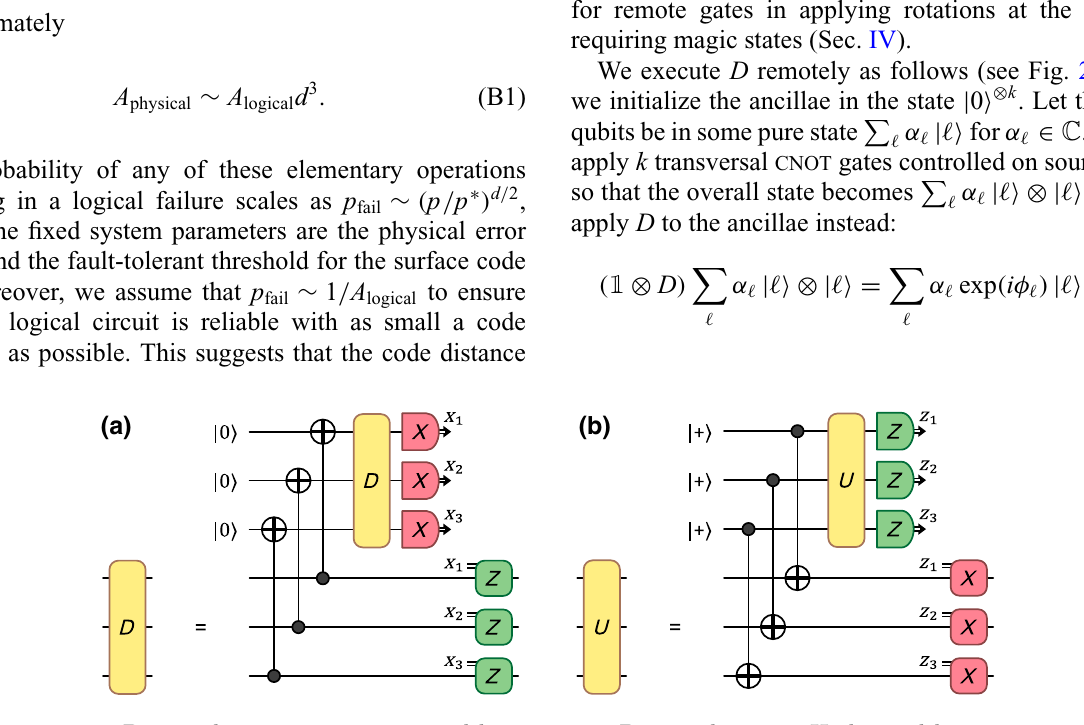
FIG. 20. (a) Any k -qubit gate diagonal in the computational basis can be remotely executed on k dedicated ancillae by first using CNOT gates. We use this technique to apply remote Z (θ) rotations [Fig. 10(b)] with magic states at the boundary. (b) Similarly, gates diagonal in the Hadamard basis also have a remote implementation. Since the Pauli corrections can be commuted through Clifford circuits, Clifford circuits can be executed immediately after executing the CNOT operations with no need to wait on the remote